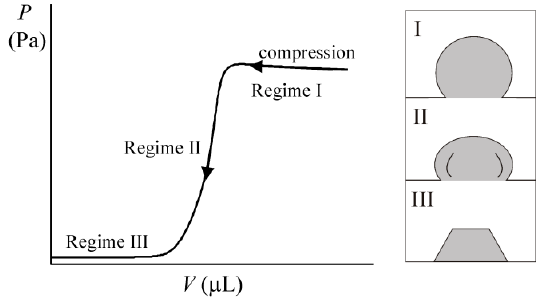
Figure 4. Behaviour of a drop coated with particles as the drop volume is reduced [60]. The pressure inside the drop increases slightly for only small reductions in the drop volume (Regime I). The interface remains fluid ‐ like and the drop profile shrinks isotropically. In Regime II, the particles pack closely together and jam. The pressure inside the drop falls to zero and the drop takes on the shape of a wrinkled hemisphere. At even larger reductions in drop volume (Regime III), the pressure is insensitive to the compression. The particle layer coating the drop buckles and flattens at the top of the drop.